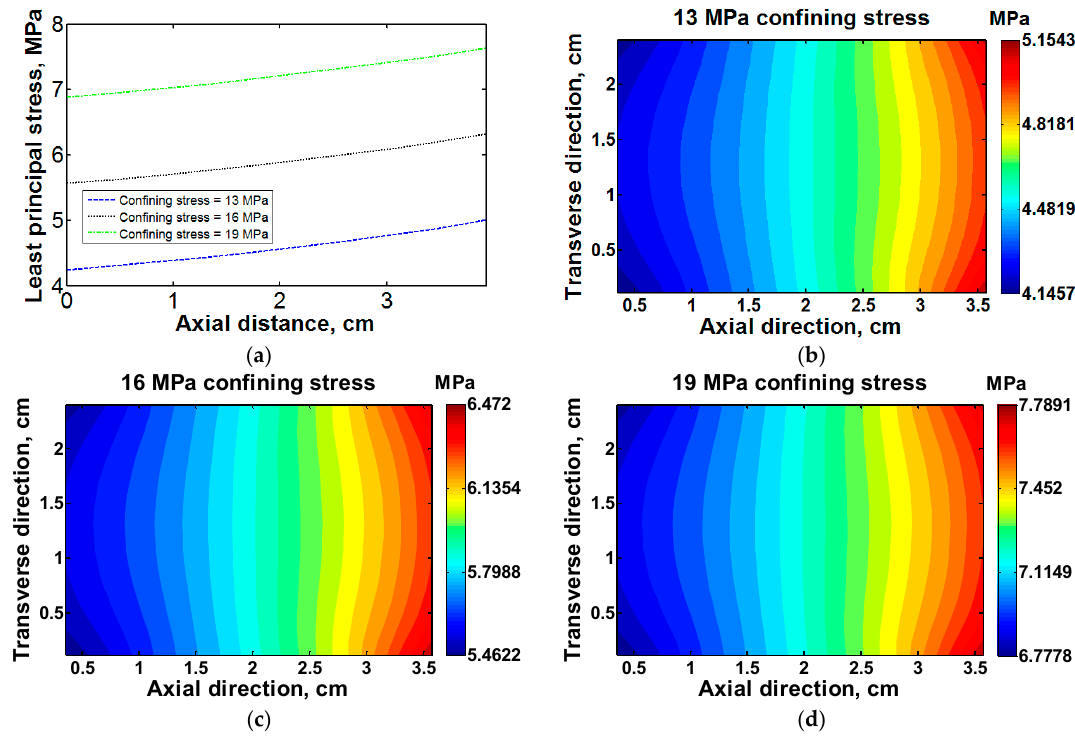
Figure 7. 1D and 2D distributions of minimum principal stress magnitude in sample LS1-16-1. ( a ) 1D distribution; ( b ), ( c ) and ( d ) are 2D distributions of minimum principal stress magnitude with confining stress 13 MPa, 16 MPa and 19 MPa respectively.